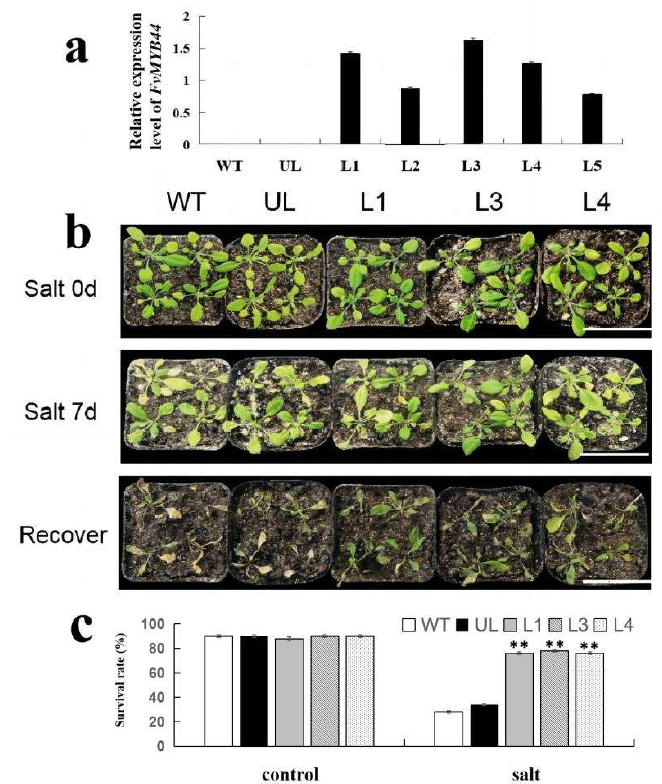
Figure 5. Transgenic A. thaliana lines that overexpress FvMYB44 grow when exposed to salt stress. In WT, UL, and 5 FvMYB44 -overexpression lines (L1, L2, L3, L4, and L5), the relative expression level of FvMYB44 was shown in ( a ). ( b ) WT, UL, and transgenic lines (L1, L3, and L4) phenotypes cultivated in a control environment, salt treatment (irrigation with 200 mM NaCl for 7 days), and recovery from salt treatment (irrigation with water for 3 days) Bar = 5 cm. ( c ) WT, UL, and transformed lines (L1, L3, and L4) survival rates. Three replicate experiments were conducted. The standard deviation is indicated by error bars. Significant differences between the WT and UL, transformed lines are denoted by asterisks (** p ≤ 0.01).